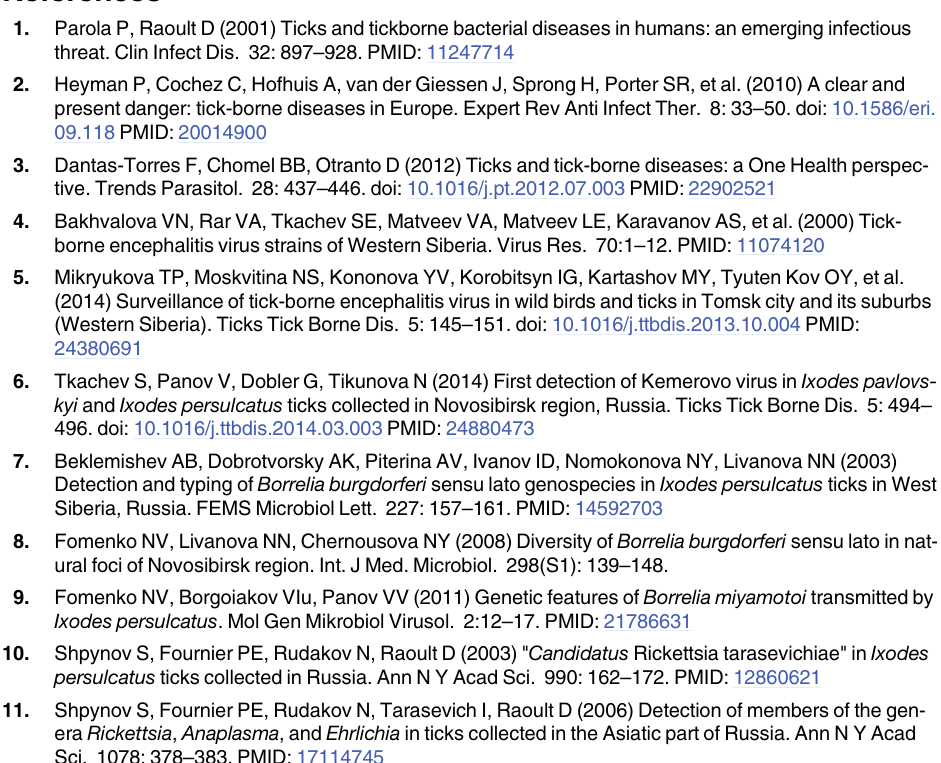
S1 Fig. MEGAN comparsion of taxonomic structure of tick groups. Samples in the tree were merged by tick species and gender. The height of the bars cohered to the log-scaled number of hits for each taxon. S1 Table. Share of all bacterial taxa in samples. Each sheet in the file describes share of taxa for specific taxonomic level: genus, family, order, class. Taxonimic level is given on the sheet